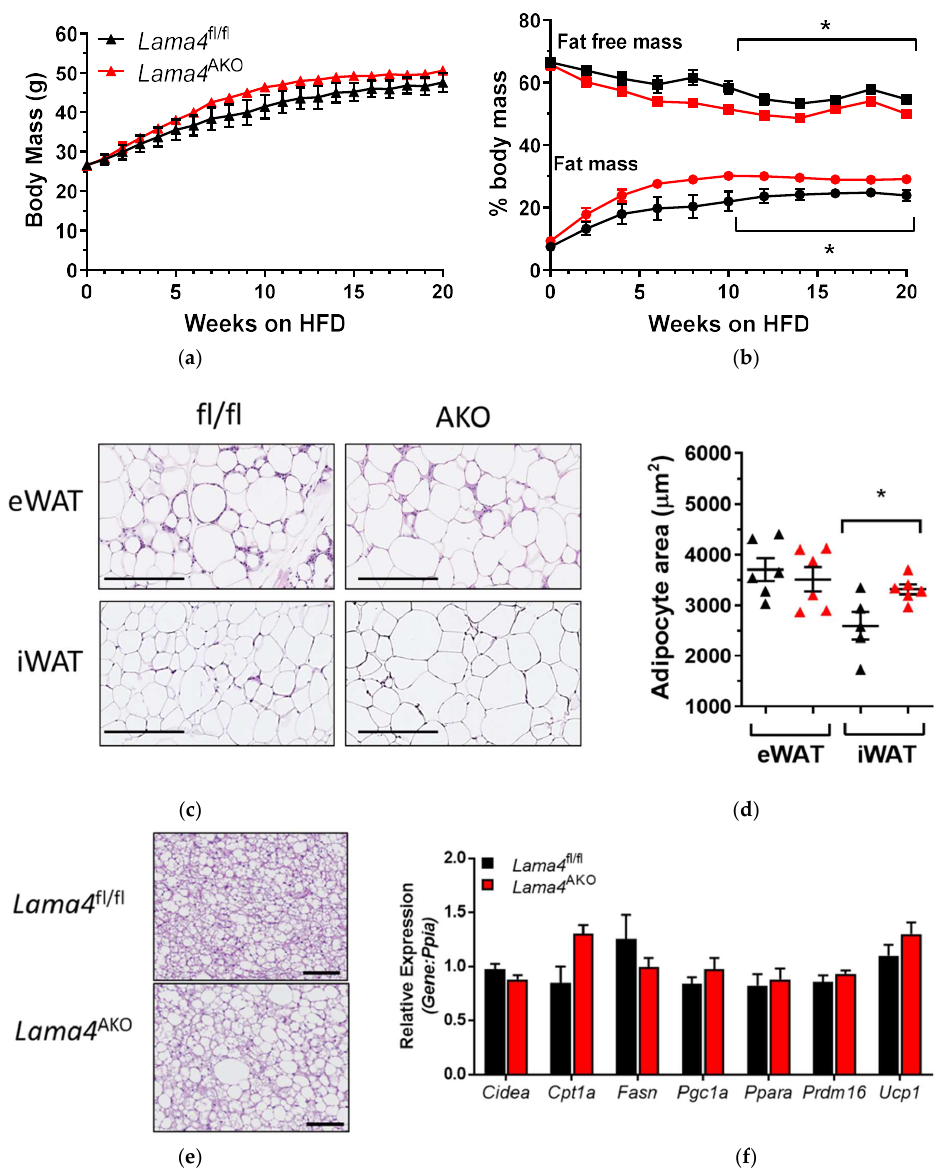
Figure 5. Mice with adipocyte-specific LAMA4 deletion have greater adiposity than control mice when challenged with HFD. Male Lama4 fl/fl (fl/fl) and Lama4 AKO (AKO) mice were provided HFD from 6–26 weeks of age; body weight was measured weekly and body composition was measured via NMR every other week. ( a ) There are no differences in body weight between Lama4 fl/fl (black) and Lama4 AKO mice (red) ( n = 16–18 per genotype). ( b ) Adiposity is significantly greater and lean mass is significantly lower ( n = 16–18 per genotype) in HFD-fed Lama4 AKO mice (red) when compared to floxed controls (black). ( c ) Representative images of H&E-stained eWAT and iWAT ( n = 4–7 per genotype). ( d ) Adipocyte area is increased in iWAT, but not in eWAT, of HFD-fed Lama4 AKO mice ( n = 4–7 per genotype). Black triangles represent Lama4 fl/fl mice and red triangles represent Lama4 AKO mice. ( e ) Larger lipid droplets are present in the BAT of HFD-fed Lama4 AKO mice ( n = 4–6 per group), but these morphological changes do not translate to altered BAT gene expression ( f ). * p < 0.05 between genotypes. Scale bars = 250 µ